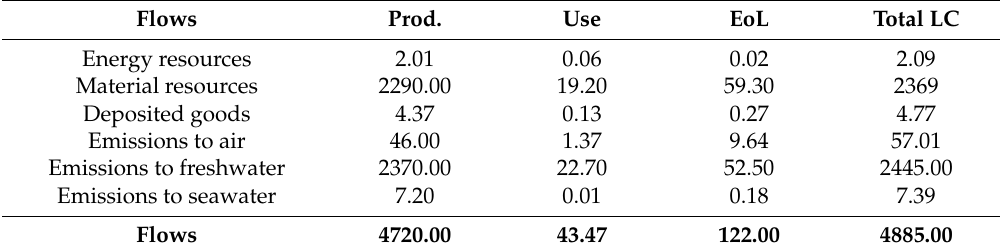
Table 2. Absolute values of resources and emissions in the life cycle stages without looping. (Functional unit: 1 kg of polypropylene product. Weighting quantity: mass, normalization unit: kilogram. Impact assessment method: CML 2016).